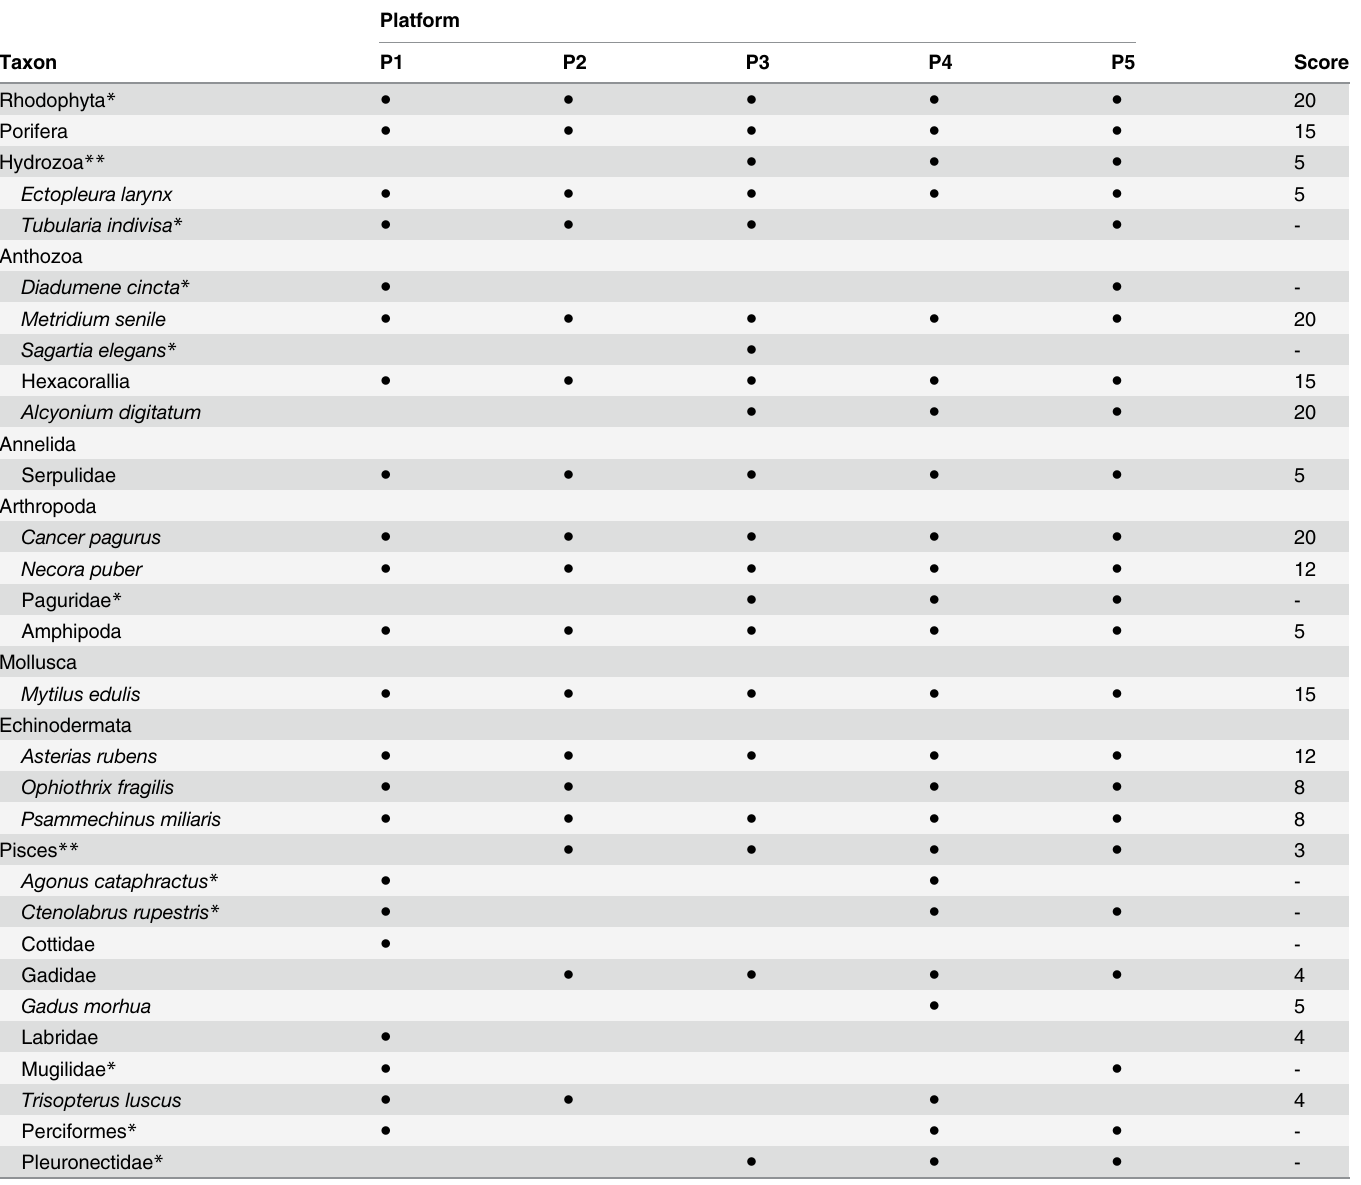
Table 3. All observed taxa ( ● ) per platform with detectability scores ( (cid:1) 6 = low, > 6 high).